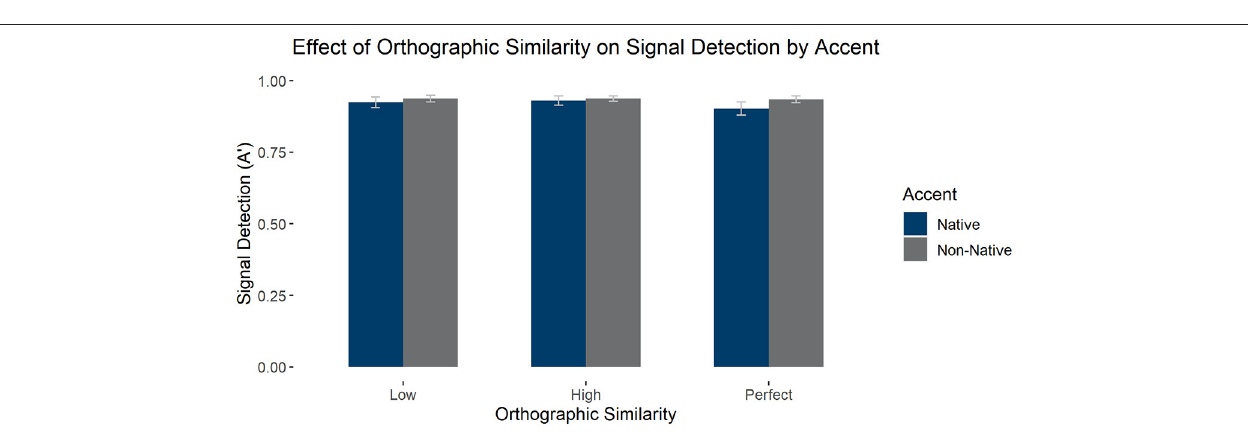
FIGURE 5 | Average signal detection (as measured by A’) in the LDT to high phonological similarity words by accent and orthographic similarity condition. Error bars mark 95% confidence